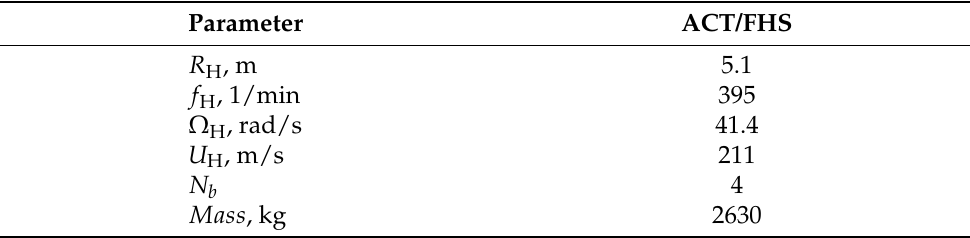
Table 5. Properties of the helicopter model used in the piloted